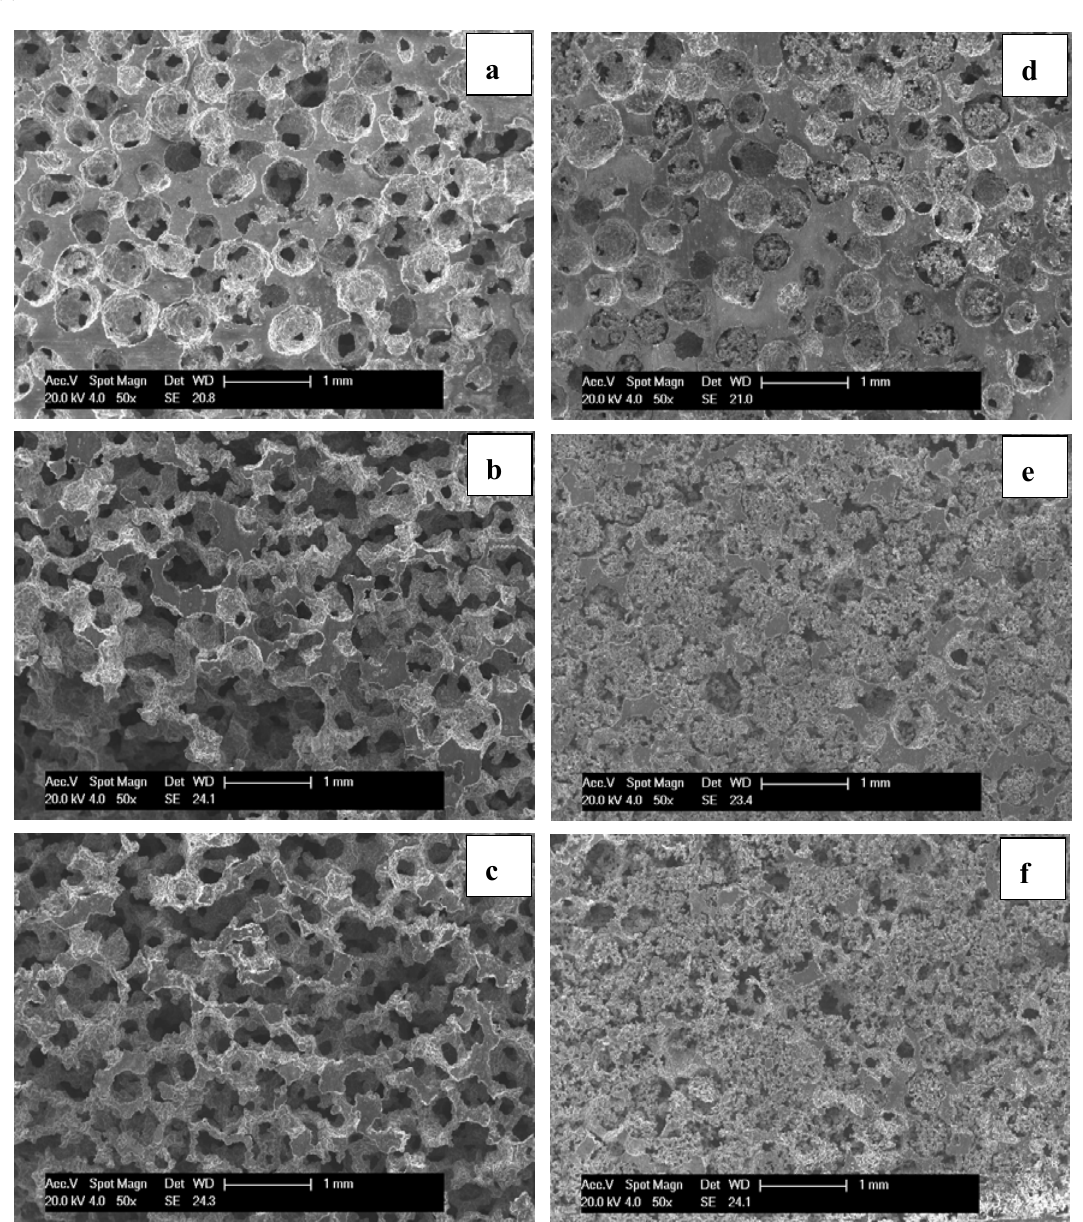
Figure 2. SEM images of infiltration in 0.5–1.0 mm bead preforms compacted at ( a ) 32 MPa; ( b ) 39 MPa; and ( c ) 50 MPa at 1 bar; and ( d ) 32 MPa; ( e ) 39 MPa and ( f ) 50 MPa at 2.5